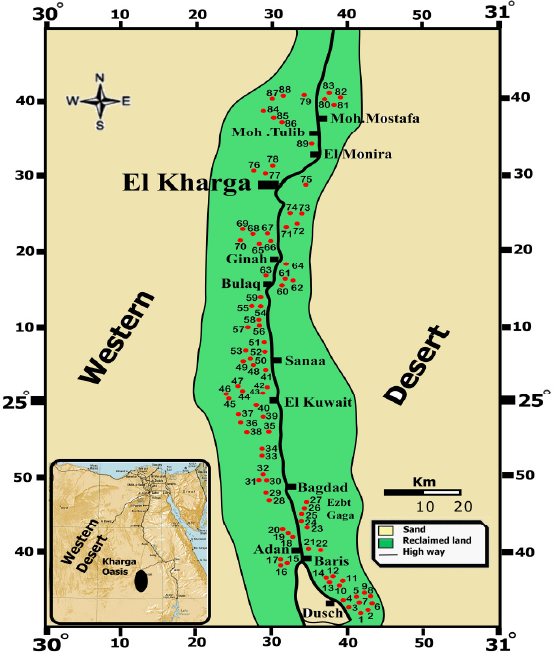
Fig. 1. Location map of Kharga Oasis, showing the distribution of the studied